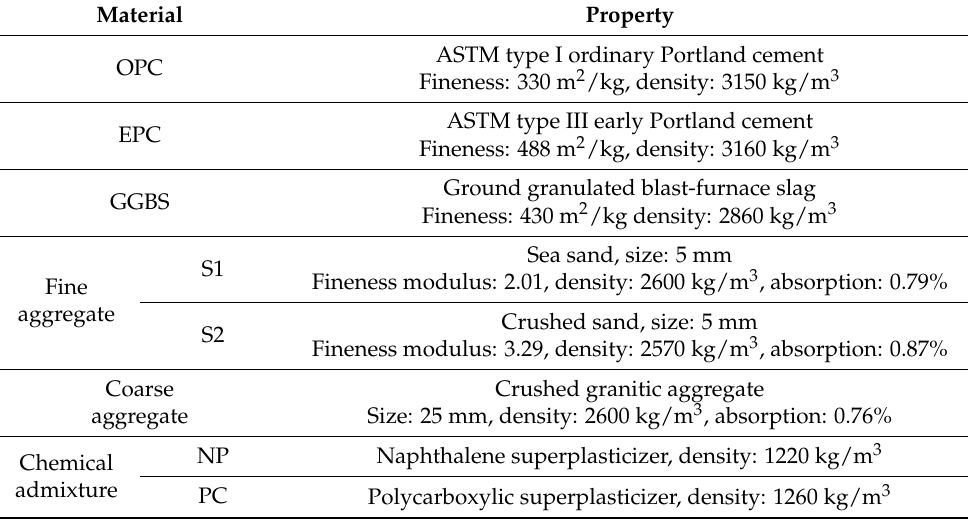
Table 1. Physical properties of the used materials.